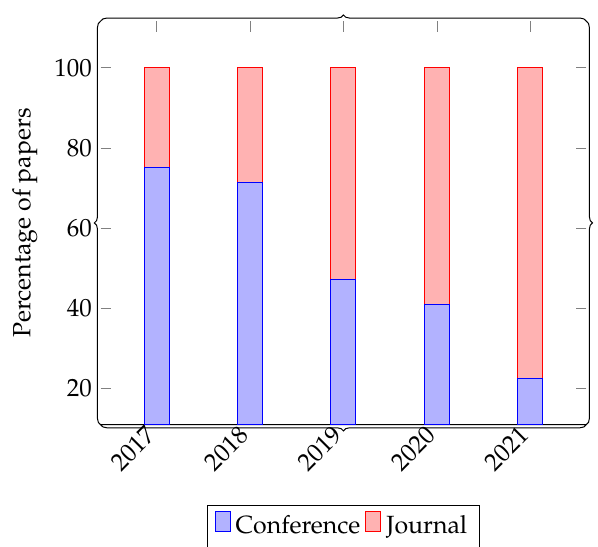
Figure 3. Publication outlet.